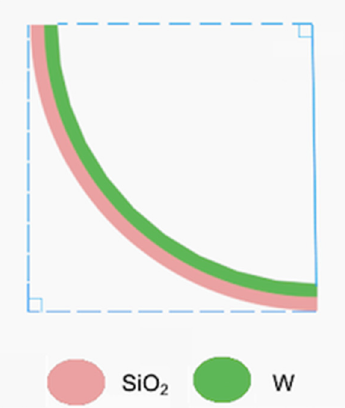
Figure 5. A W/SiO 2 vertically-bent bimorph beam used in a 90° tilting structure.